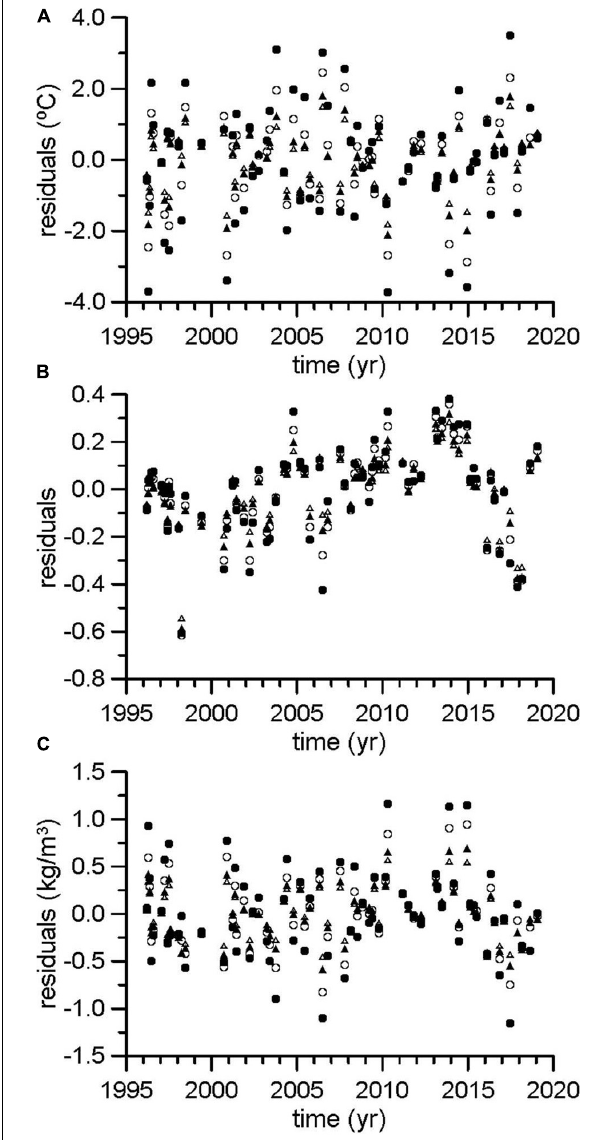
FIGURE 3 | Residuals or anomalies of potential temperature (A) , salinity (B) , and potential density (C) for the AW layer. Residuals are obtained subtracting a seasonal cycle to the original time series. For each variable, four different time series are presented. The first one is made of the mean value of the upper 25 dbar (black filled circles), 50 dbar (open circles), 75 dbar (black filled triangles), and 100 dbar (open